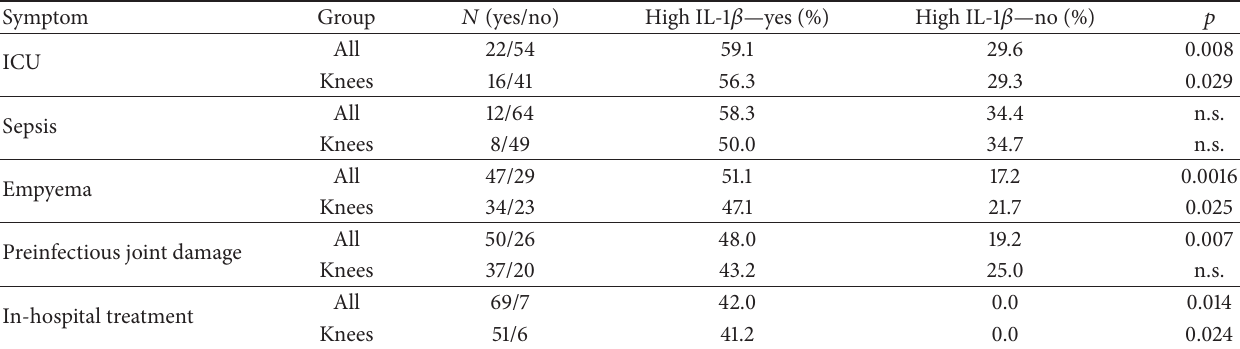
Table 1: The overview shows the relative expression of IL-1 𝛽 in relation to clinical parameters. ICU: necessity of intensive care treatment; sepsis: fulfilment of clinical sepsis criteria; empyema: fulfilment of clinical empyema criteria; preinfectious joint damage: any lesion including osteoarthritis; in-hospital treatment: the difference to an outpatient treatment ( < or ≥ 0.005, 𝜒 2 -test; ICU: intensive care unit, n.s.: not significant).